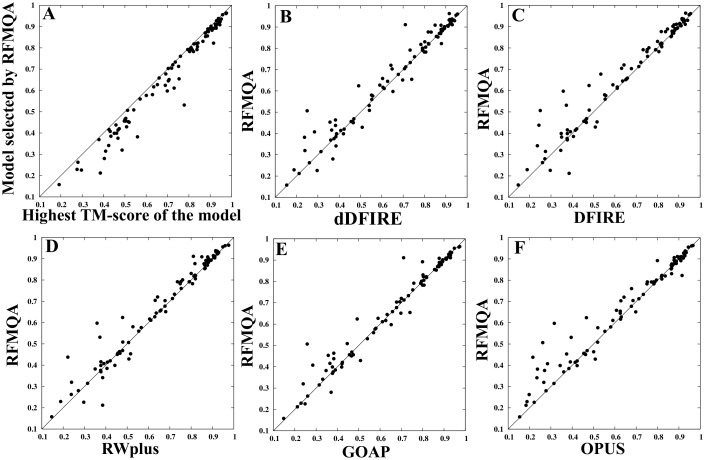
Evaluation of RFMQA on CASP10 targets and its pairwise comparison with other potential energies.(A) TMRF versus TMbest. Pearson's correlation coefficient and the average TMloss between TMRF and TMbest are 0.984 and 0.039, respectively, (B) dDFIRE versus RFMQA, (C) RWplus versus RFMQA, (D) OPUS versus RFMQA, (E) GOAP versus RFMQA, and (F) DFIRE versus RFMQA.